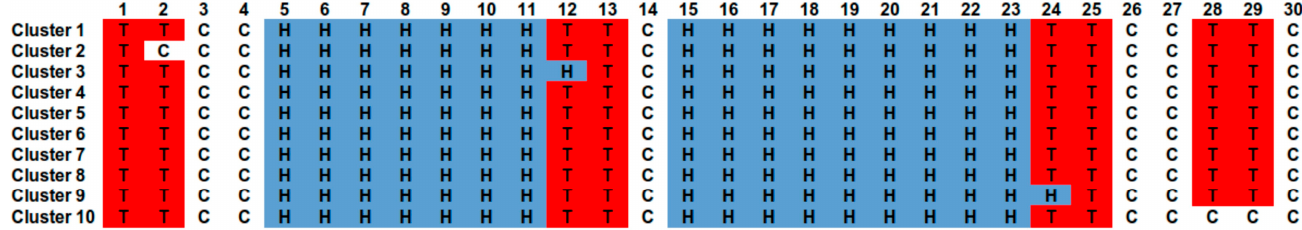
Figure 4. Consensus secondary structure for the top 10 clusters. H: helix, T: Turn, C: Coil.